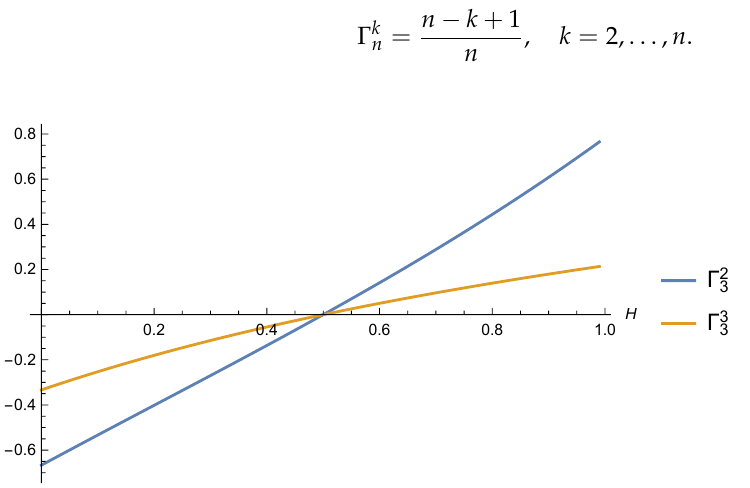
Figure 9. Case n = 3: Γ 2